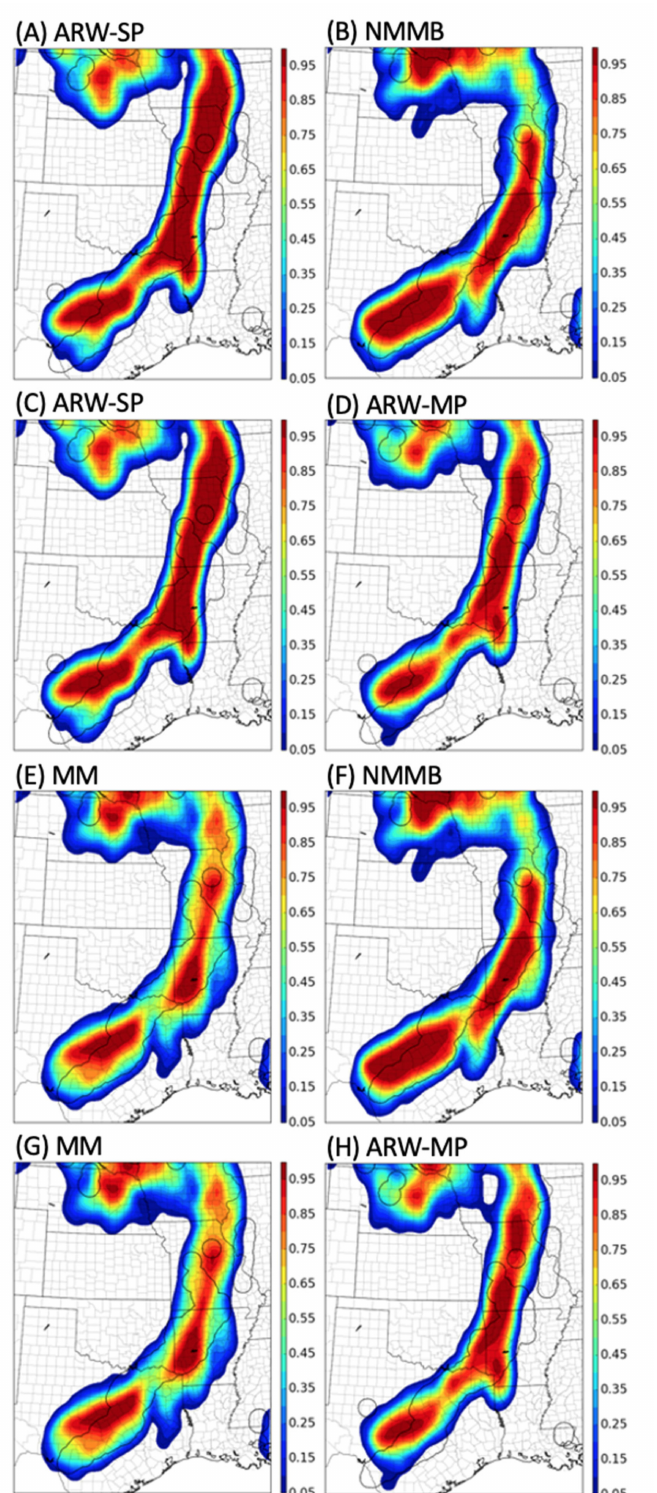
Figure 10. As in Figure 8, but for NMEP plots with a radius of 16 grid points. Each ensemble- to-ensemble comparison is organized by column: SMSP ( A , B ), SPMP ( C , D ), MMSM ( E , F ), and MPMM ( G , H